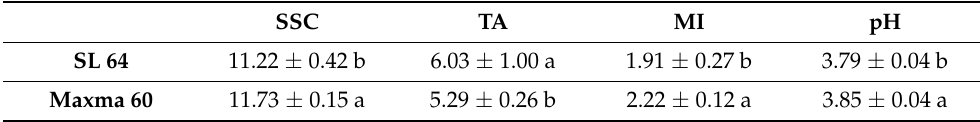
Table 2. Soluble solids content (SSC) ( ◦ Brix), titratable acidity (TA) (g malicacid 100 g − 1 of FW), maturity index (MI) (SSC/TA) and pH values of sweet cherry cv. Early Bigi grafted on SL 64 and Maxma 60 rootstocks. Different letters indicate statistically significant differences ( p < 0.05) according to Duncan’s